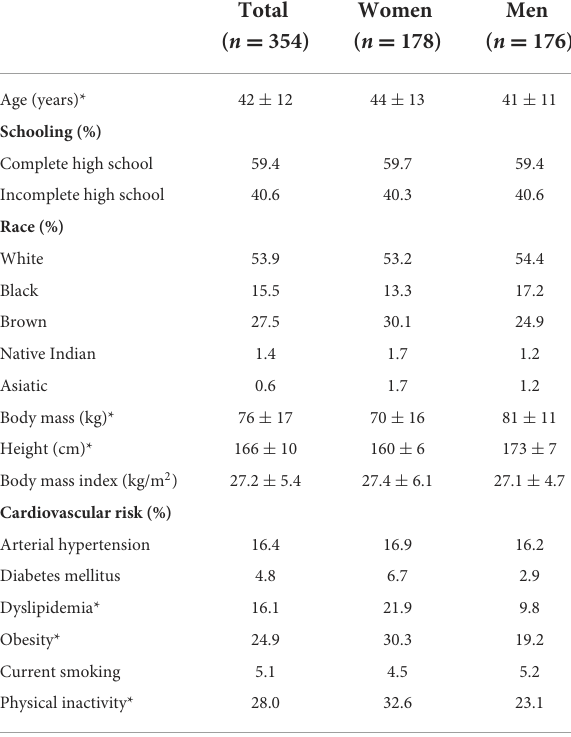
TABLE 1 General characteristics of the studied sample. TABLE 2 General characteristics of the studied sample stratified